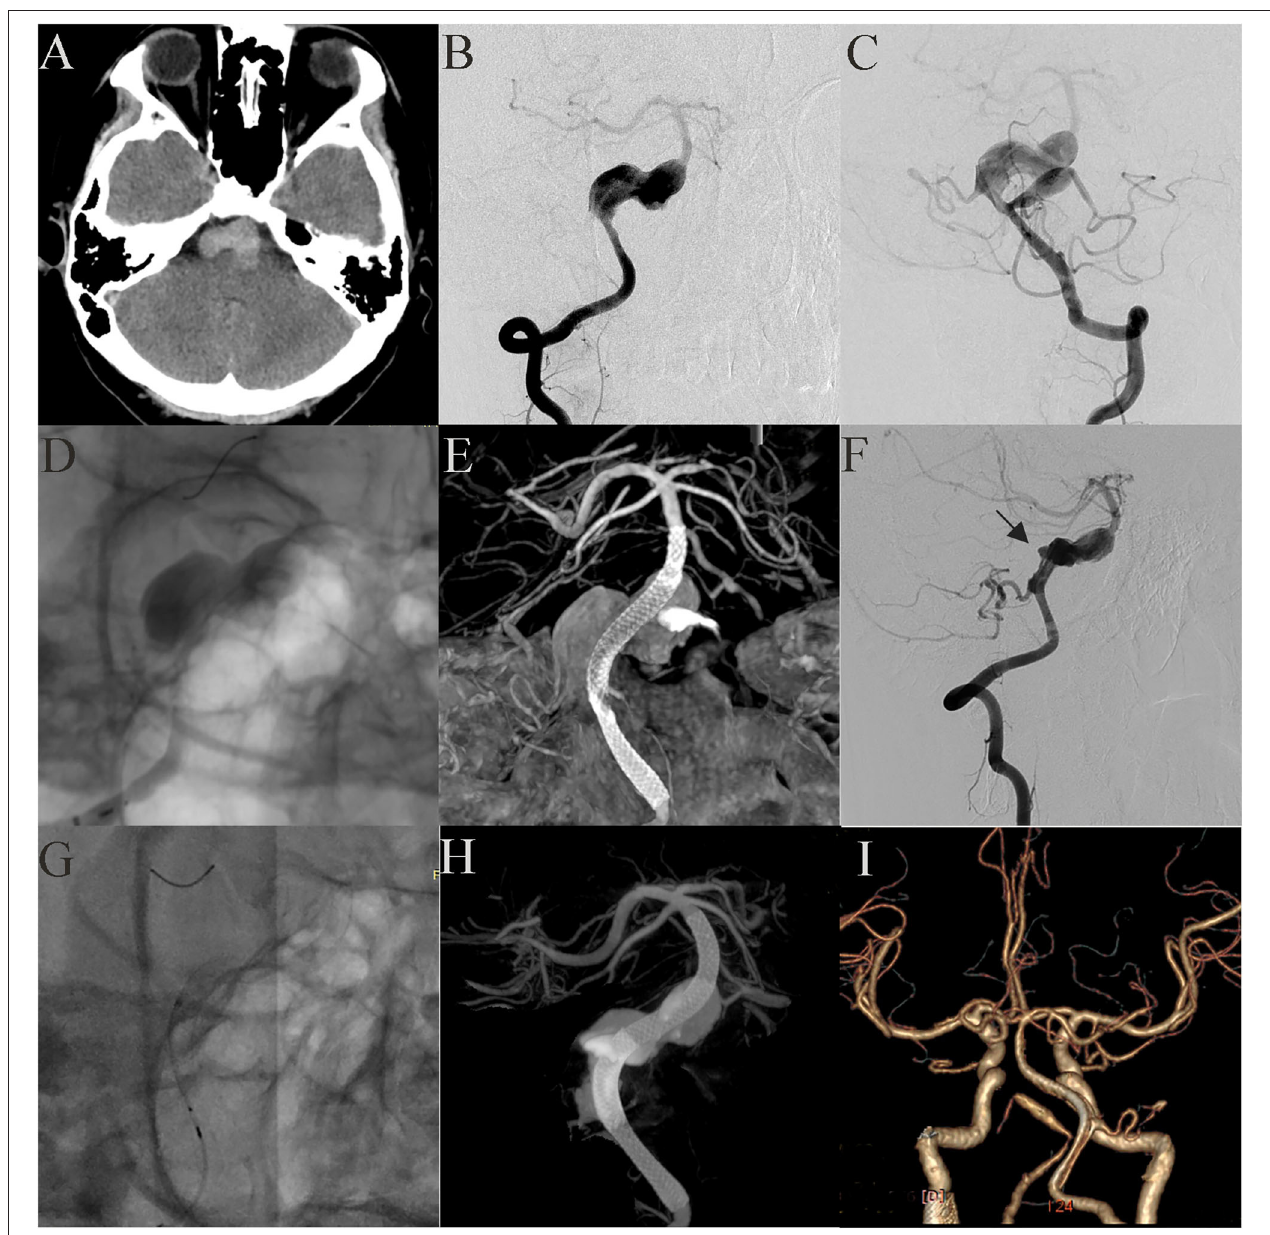
FIGURE 4 | Case 21: A 17-year-old boy had a giant vertebrobasilar artery aneurysm and a PICA aneurysm ( A , CT scanning; B, C , anteroposterior projections of bilateral vertebral arteries). A 3.75mm × 35mm PED was successfully deployed from the basilar artery to the right vertebral artery. Post-embolization angiograms showed significant contrast stasis (D) and good vascular reconstruction (E) . The left PICA aneurysm was untreated. Two weeks later, the distal end of the stent (black arrow) retracted and fell into the aneurysm cavity (F) . Another PED was used to bridge the original PED (G, H) . Three months later, CTA examination showed that the aneurysm was completely occluded (I)